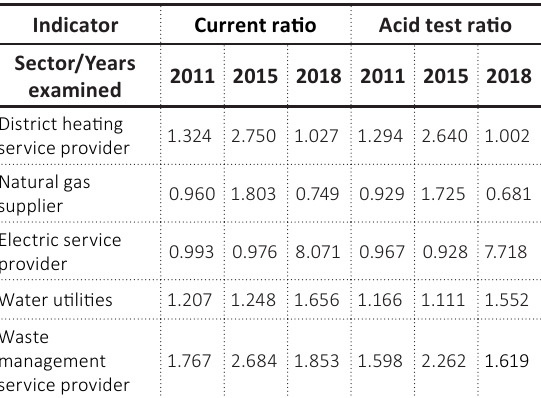
Table 1. Changes in the financial